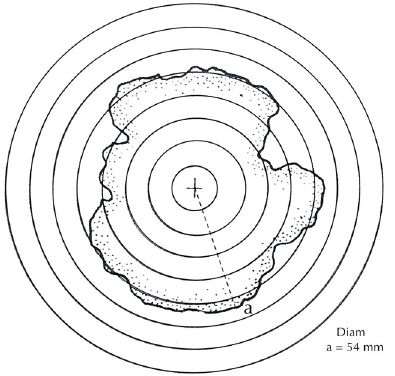
Figure 6. Measurement methods: acetate film inscribed with 5 mm concentric circles, with diameters judged by eye to the nearest 1 mm, to be fitted to the circumferences of near circular thalli and useful for detecting potentially fused thalli [80].